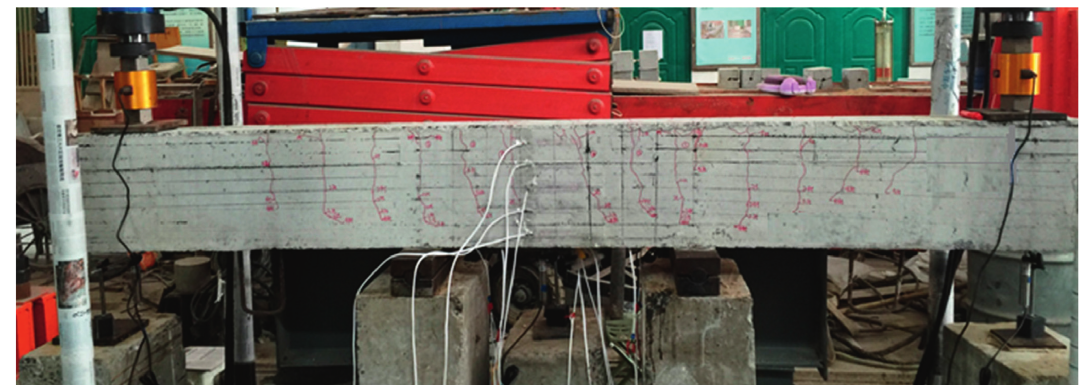
Figure 2: Actual RC beams with 600MPa steel bars and the test device.